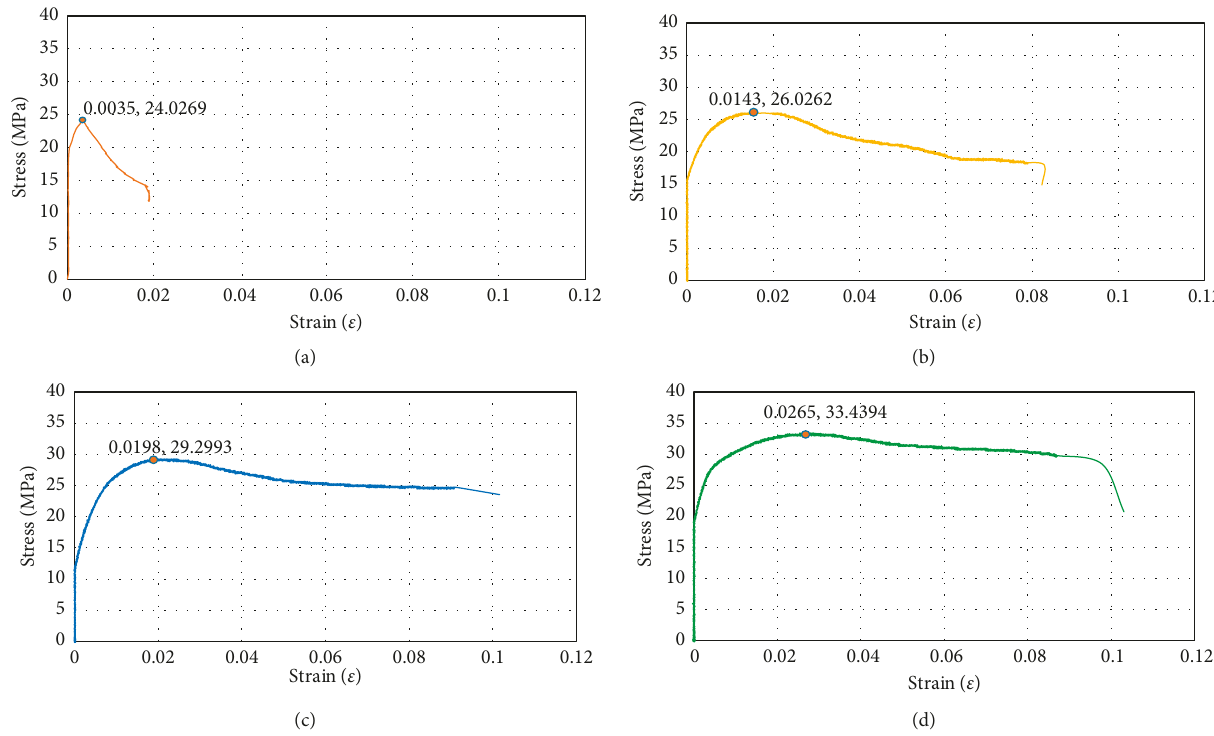
Figure 4: Experimental stress-strain curves of test specimens: (a) specimen C 16.926), and (d) specimen C F3 ( Z m3 (c) specimen C F2 ( Z m2 (cid:31)